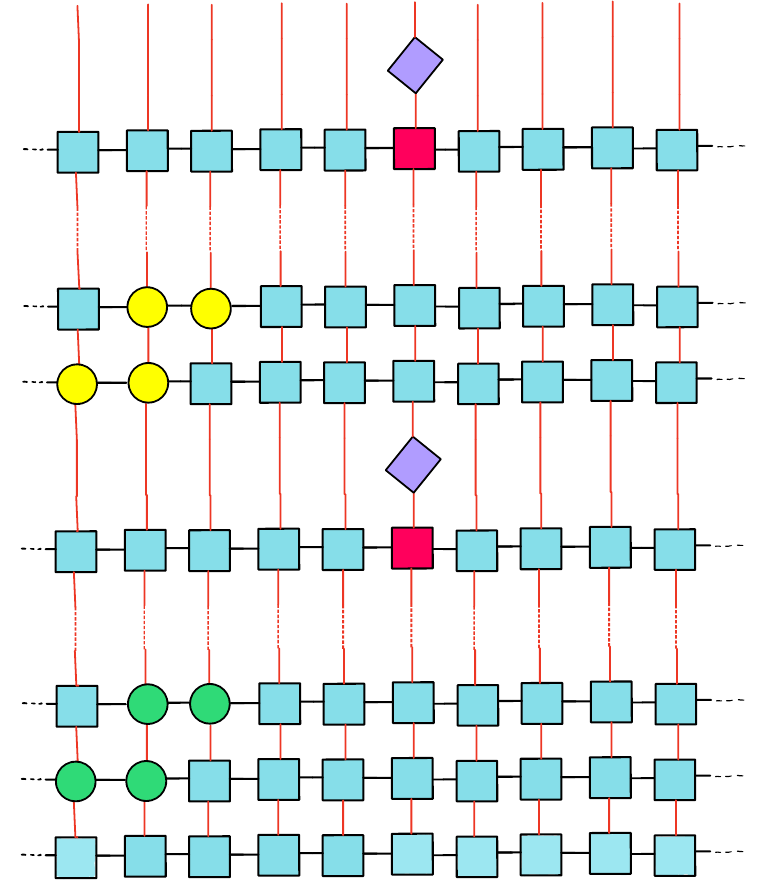
Figure 9: The green and yellow tensors denote the two-site centers of the mixed canonical form for the forward and backward time evolution respectively. This changes with sweeps left to right and right to left [ 49 ] . The sweeps on the network depends on the instantaneous Hamiltonian. Each layer depends on the instantaneous Hamiltonian. After time evolution to the desired time, the central site is made the one-site center of the mixed canonical form (red tensor) and acted on with Z is denoted by the violet